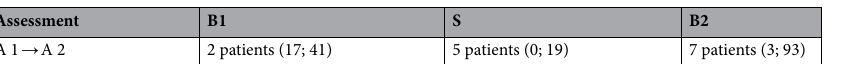
Table 2. Number of patients with significant changes in age-corrected average clustering coefficient of evolving functional brain networks ( p < 0.05) between assessments A1 and A2 for each period (B1, S, B2) (range of Wilcoxon signed rank test W values in